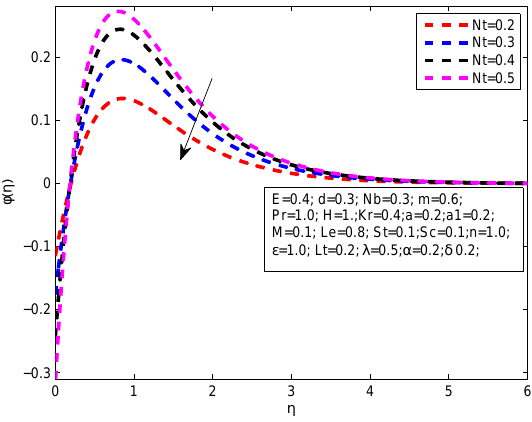
Figure 12. Variation of φ for distinct values of Nt .